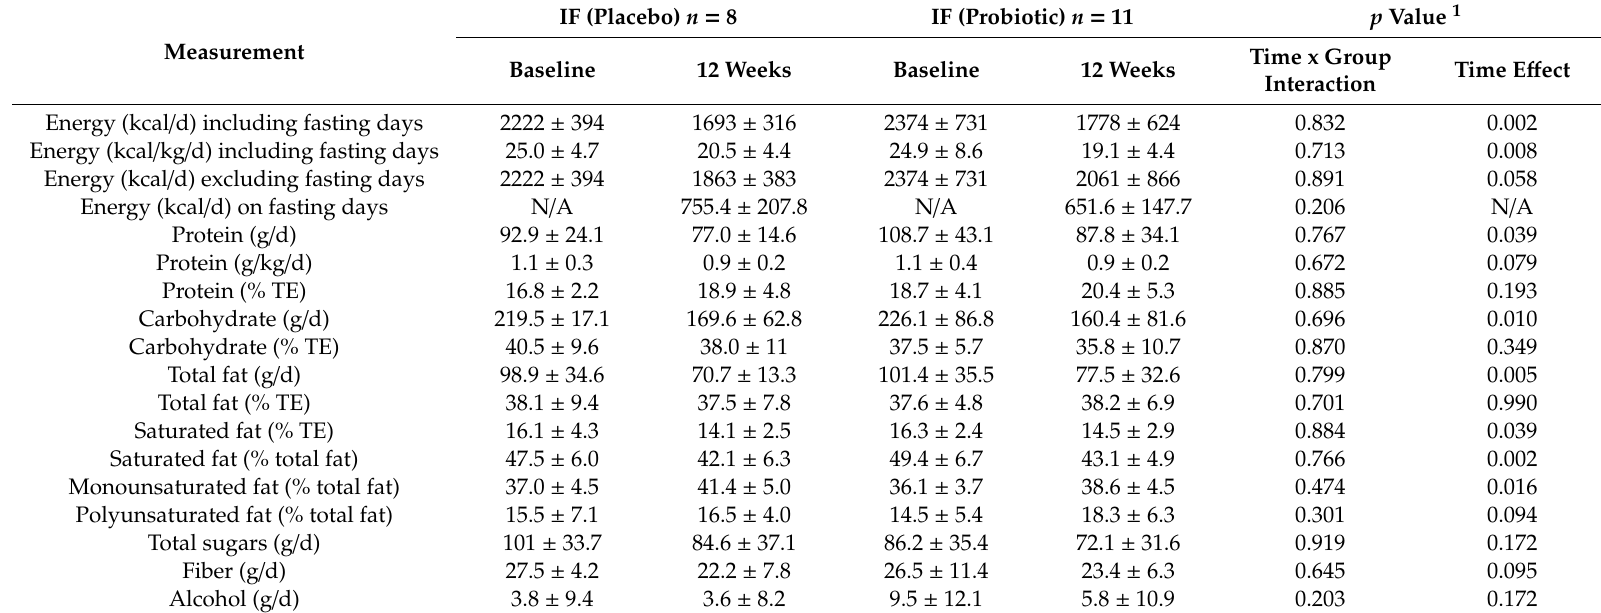
Table 3. Comparison of energy and macronutrient intake at baseline and after 12 weeks of IF in the IF placebo and probiotic groups. IF (Placebo) n = 8 IF (Probiotic) n = 11 p Value 1 Measurement Baseline 12 Weeks